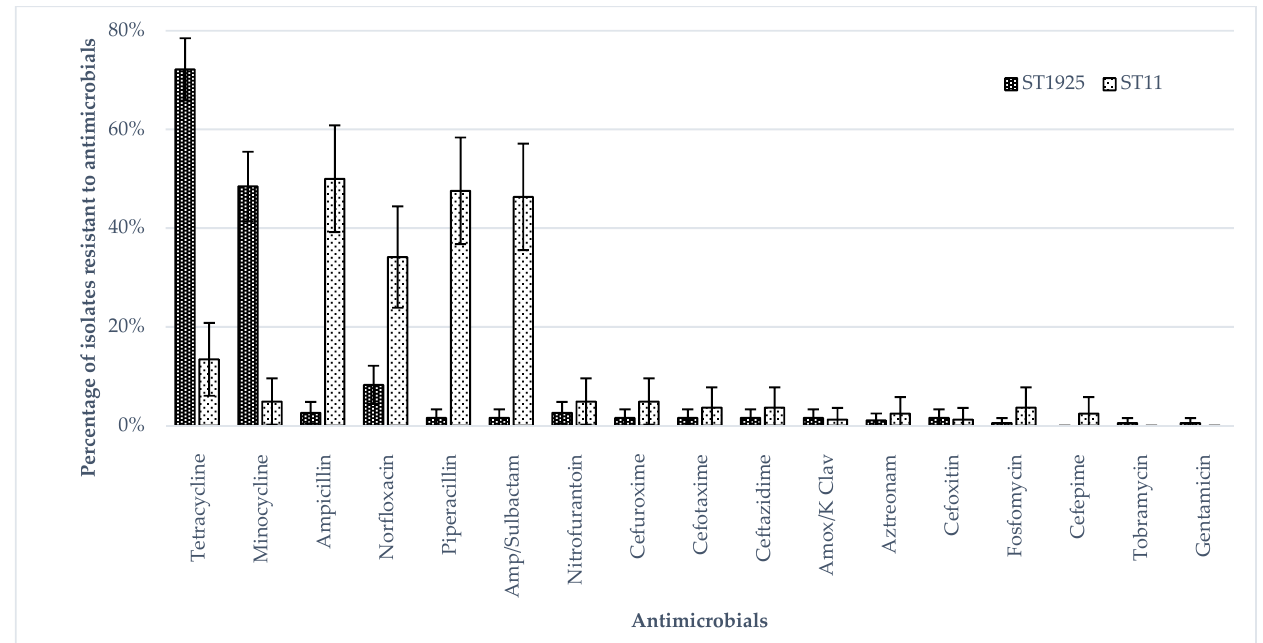
Figure 2. Phenotypic antimicrobial resistance in S. enteritidis , comparing intestinal and extra- intestinal human isolates.